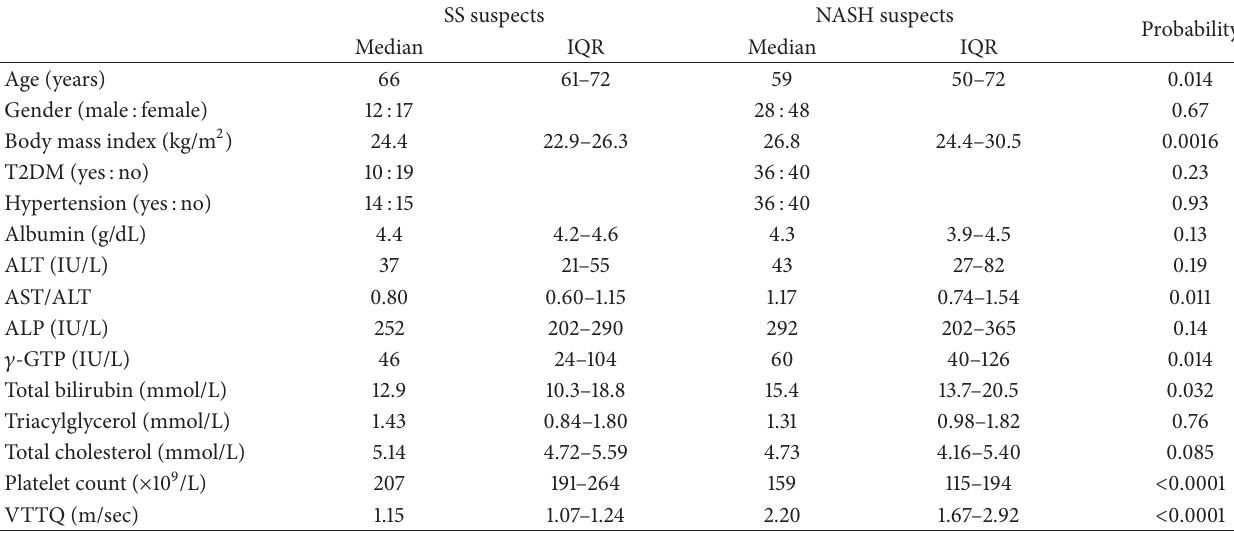
Table 2: Univariate comparison between SS and NASH suspects.